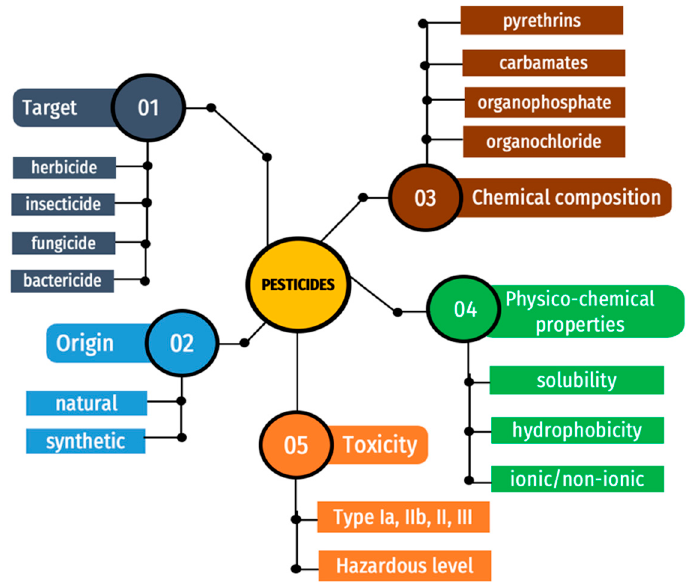
Figure 1. General classifications of pesticides.